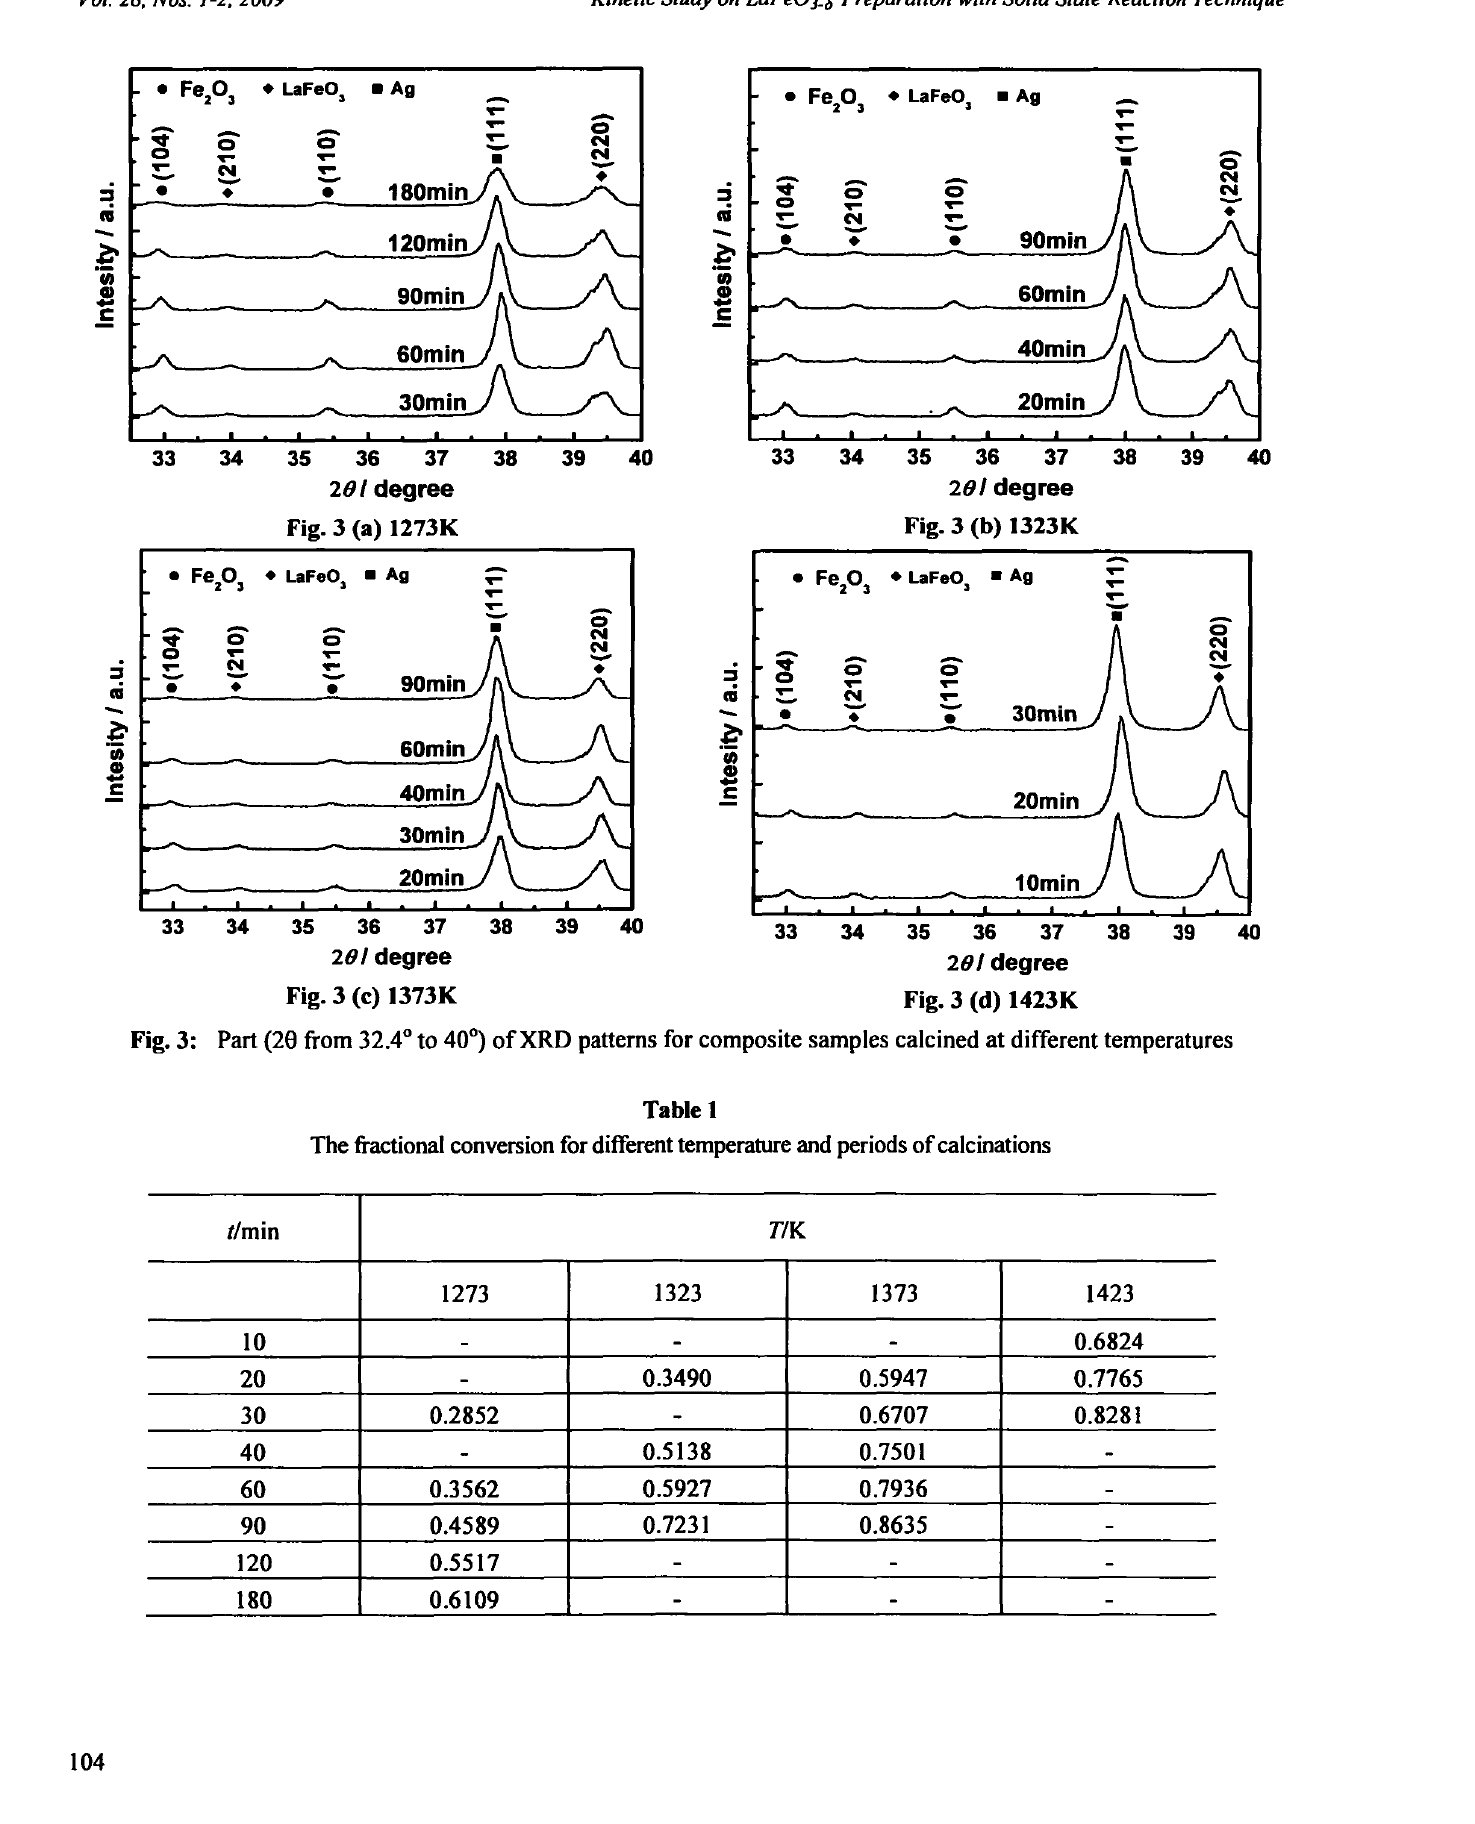
The fractional conversion for different temperature and periods of calcinations